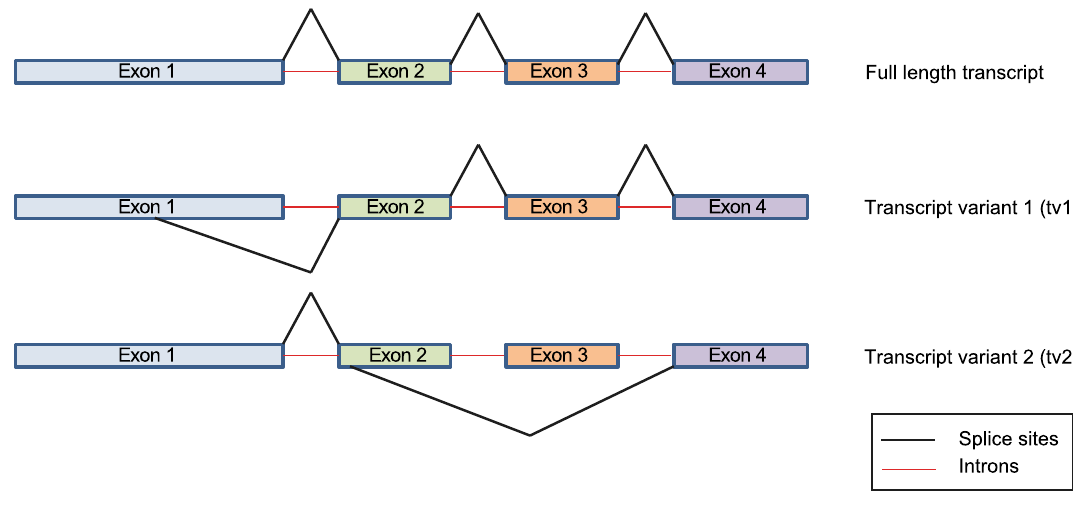
Figure 1. mRNA structure of full length SfUGT33F28 transcript and